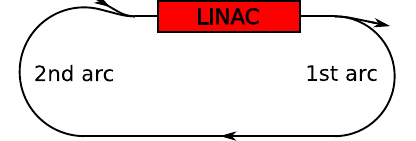
FIG. 1. Layout of the double-pass scheme.